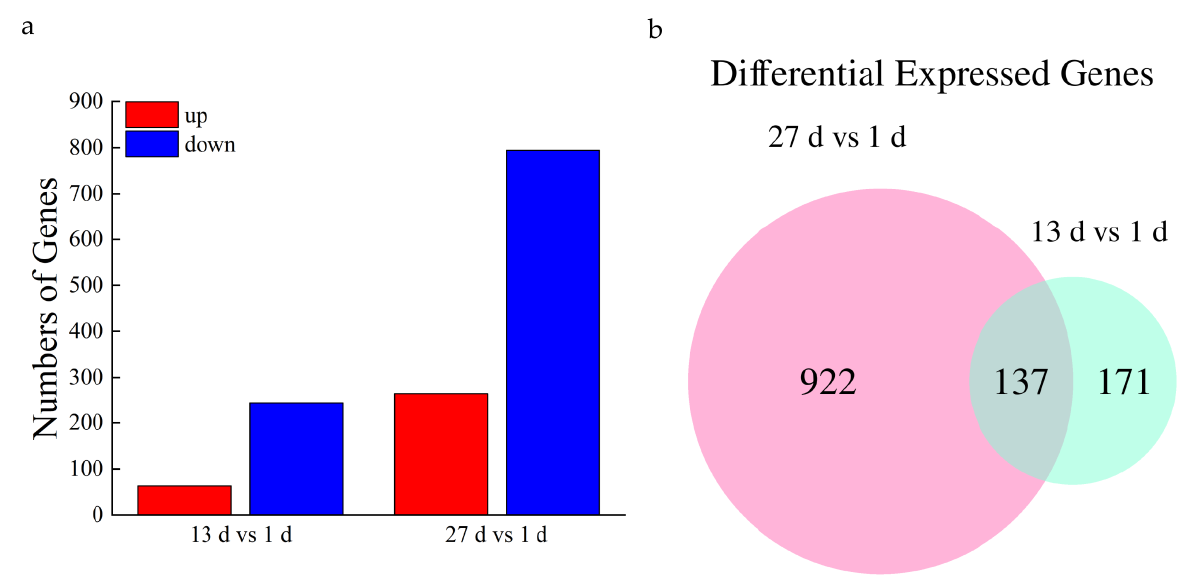
Figure 5. Histogram ( a ) and Venn diagram ( b ) of differentially expressed